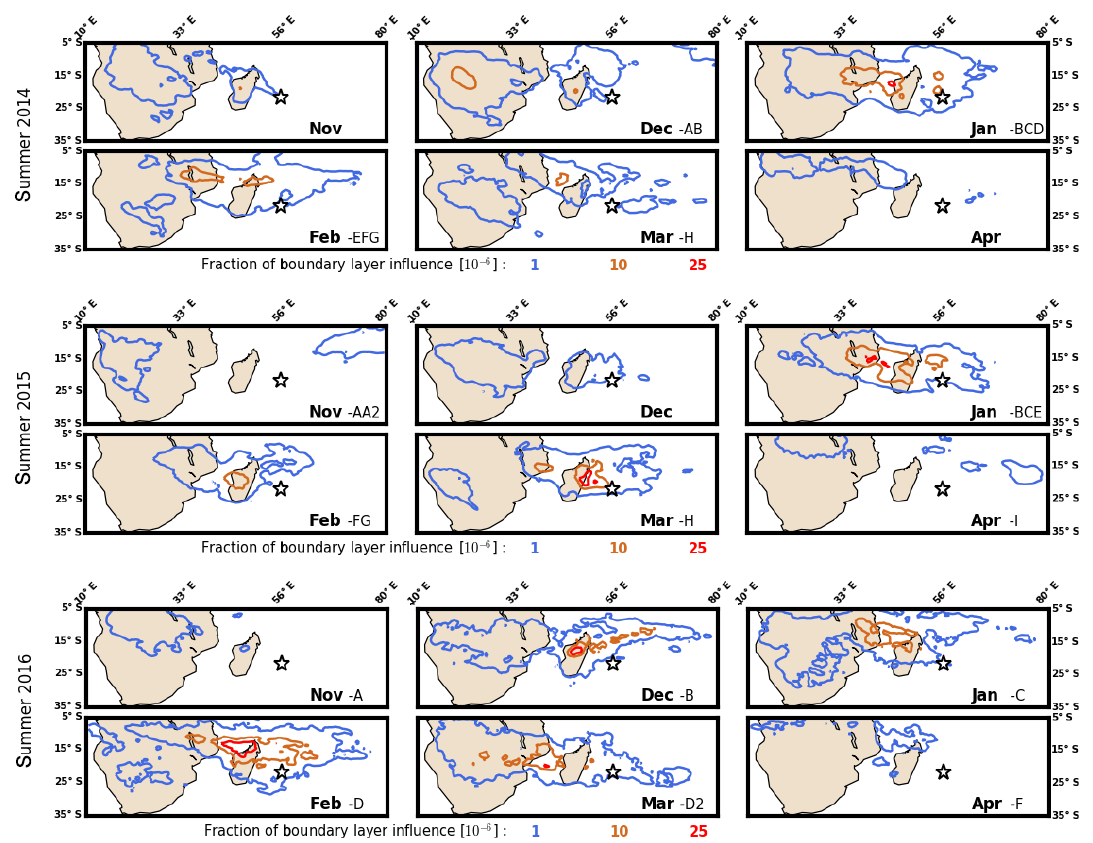
Figure 11. Monthly-average product of DCCO and RTLT normalized by the total residence time in the whole atmospheric column. From top right to bottom left: November 2013, December 2013, January 2014, February 2014, March 2014, April 2014, November 2014, Decem- ber 2014, January 2015, February 2015, March 2015 and April 2015. The values for each contour are indicated by the numbers in blue, orange and red at the bottom of each panel. The location of Réunion island is indicated by a white star in each plot. In each subplot, the letters indicate tropical cyclones that occurred during a given